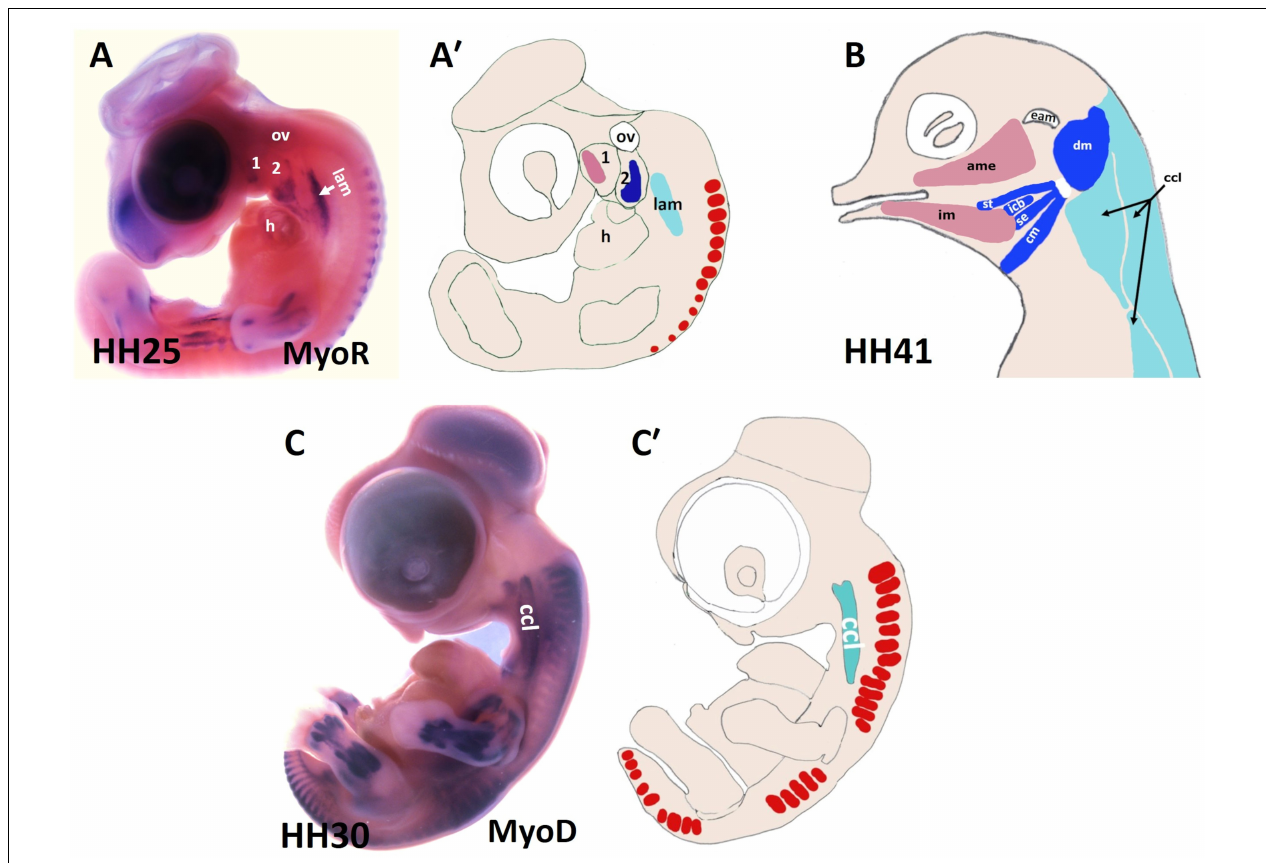
FIGURE 2 | Muscles of the chicken head and neck. (A,C) Lateral view of chicken embryos hybridized with DIG-probes for either MyoR (A) or MyoD (C) . (A (cid:48) ,C (cid:48) ) Schematic representation of chicken embryos in the panels (A,C) . (B) Lateral view of head muscles of a stage HH41 chicken embryo. The MyoD and MyoR delineated the BA1-derived muscles (pink), the BA2-derived muscles (blue) and the cucullaris muscle (pale blue). ame, adductor mandibulae externus; 1-2, branchial arches 1-2; ccl, cucullaris anlage; cm, caudal mylohyoideus; dm, depressor mandibulae; eam, external auditory meatus; h, heart; icb, interceratobranchialis; im, intermandibularis; lam, lateral plate mesoderm; ov, otic vesicle; se, serpihyoideus; st,